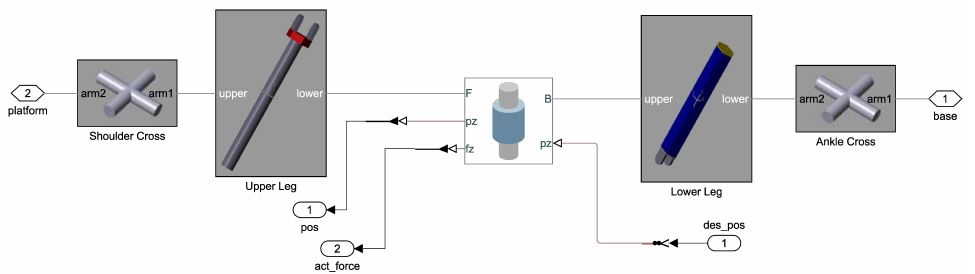
Figure 4. The Simscape model structure of one